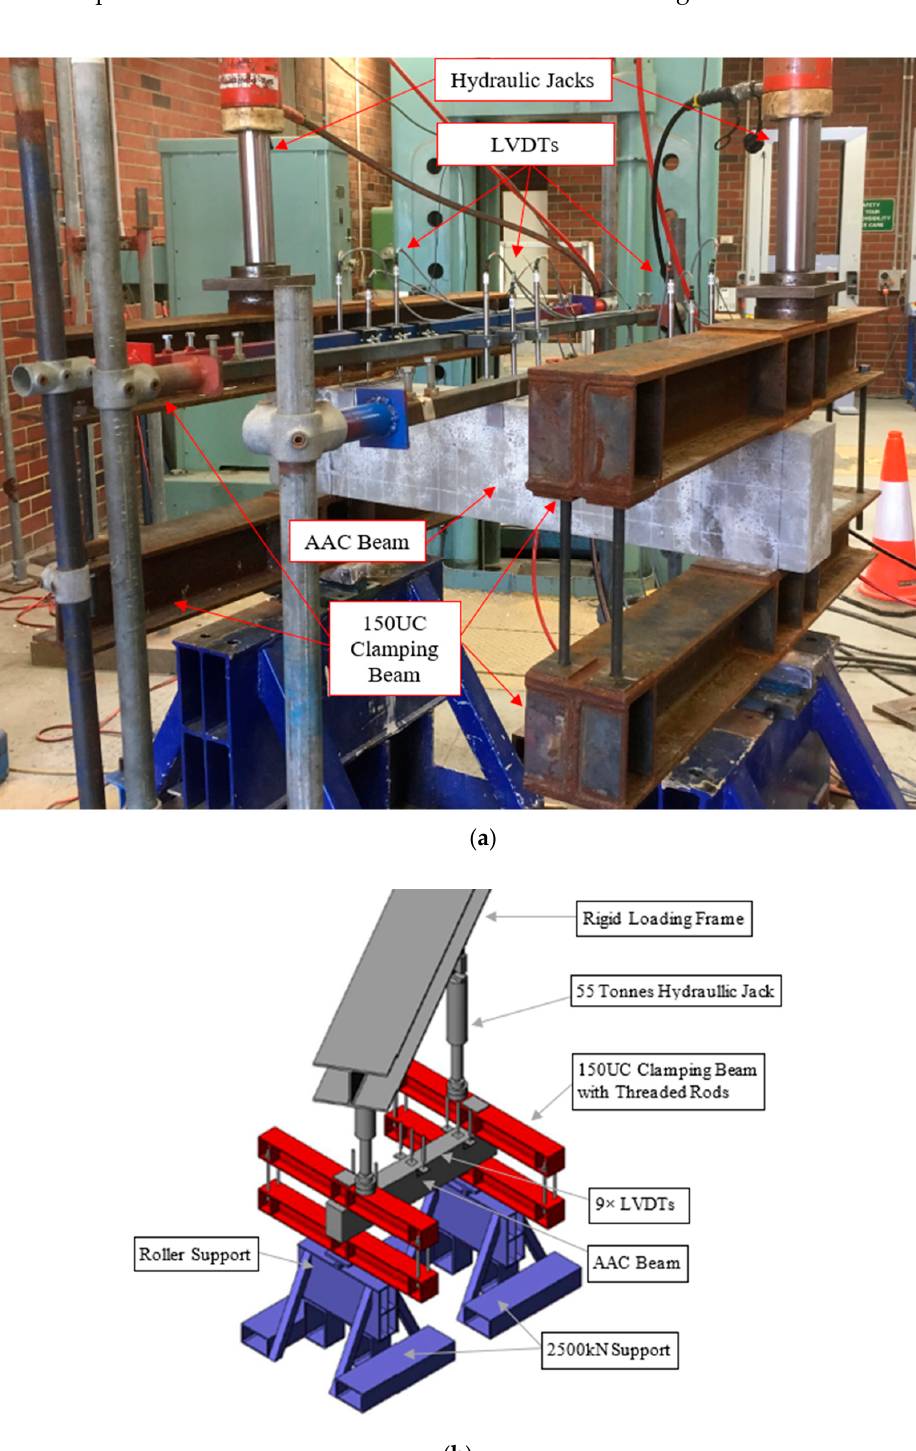
Figure 3. Torsion testing setup: ( a ) photograph of the setup; and ( b ) isometric view in 3D (the hollow section beams supporting the LVDT is not shown in the 3D sketch).